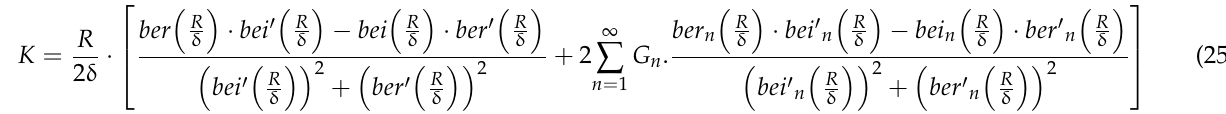
cess. The three analytical models (relation (24) with m = 1, relation (25) for an order n = 1 and the case of square bar) can be used for this bar up to a frequency of 1000 Hz. In Figure 14a,b the additional loss coefficient increases with the diameter of the bar.